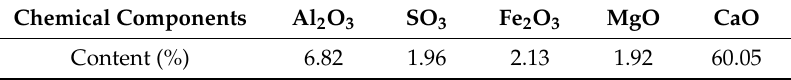
Table 1. Chemical components of